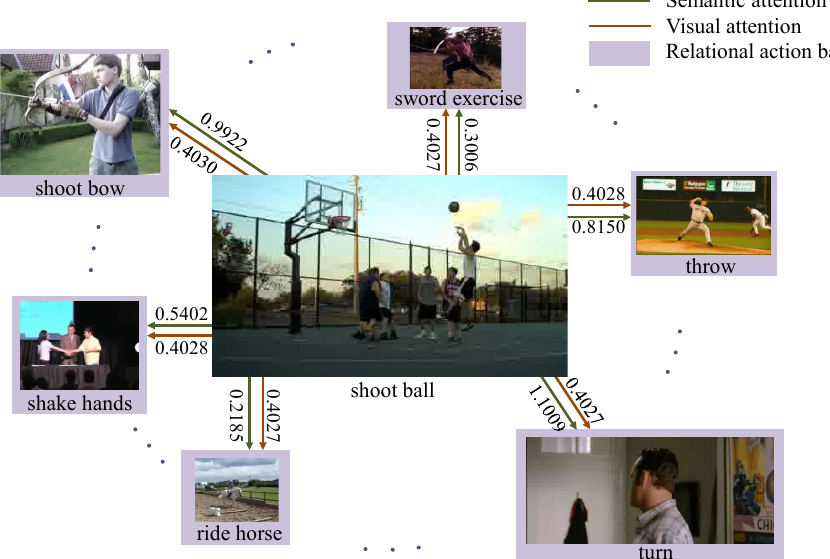
Figure 1. The relevancy between the few labelled action “shoot ball” and the actions in the relational action bank. The value on the green arrow is the output of the semantic attention submodule, which displays the semantic relevancy, and the value on the brown arrow is the output of the visual attention submodule, which displays the visual